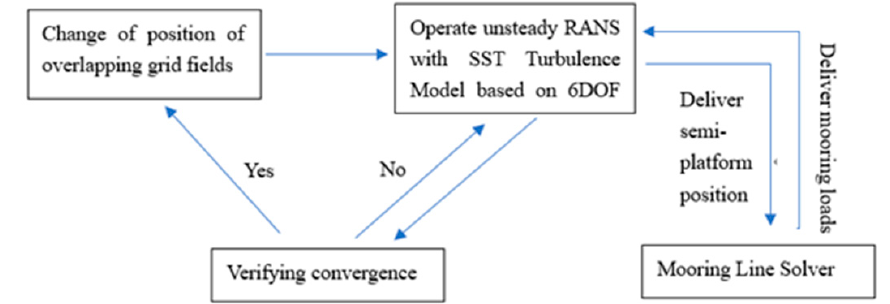
Figure 2. The operational procedure of the numerical model.